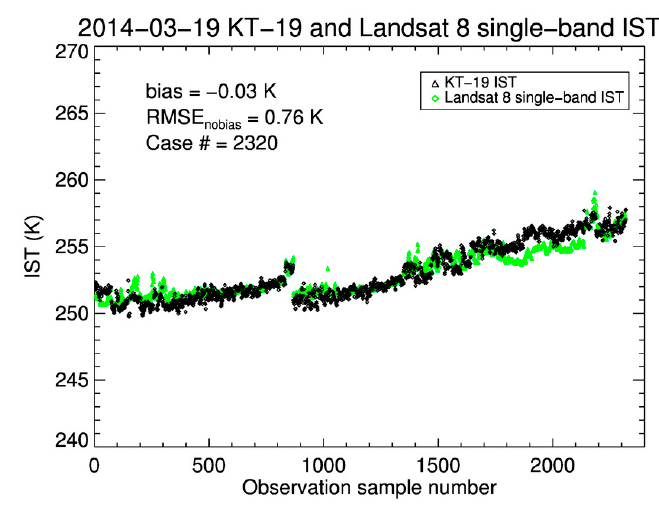
Figure 4. KT-19 ice surface temperature (IST) (black) and retrieved IST from Landsat 8 (green) along the P-3 Ice Bridge flight track from 22:37–22:38 UTC on 19 March 2014.